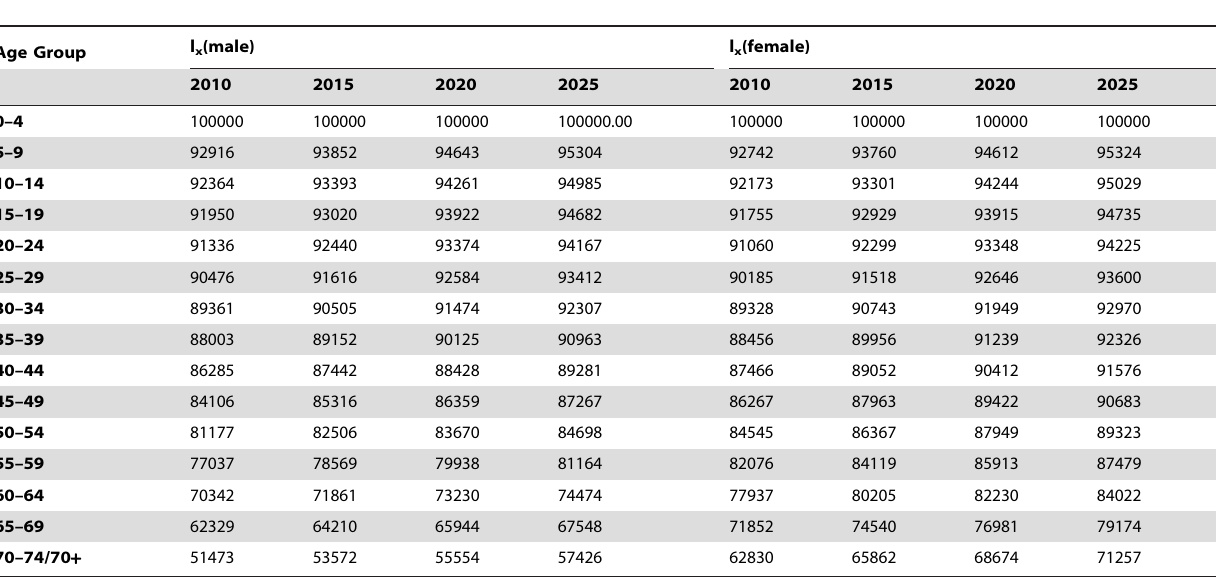
Table 6. Forecasts of numbers surviving to exact ages for selected years, India.